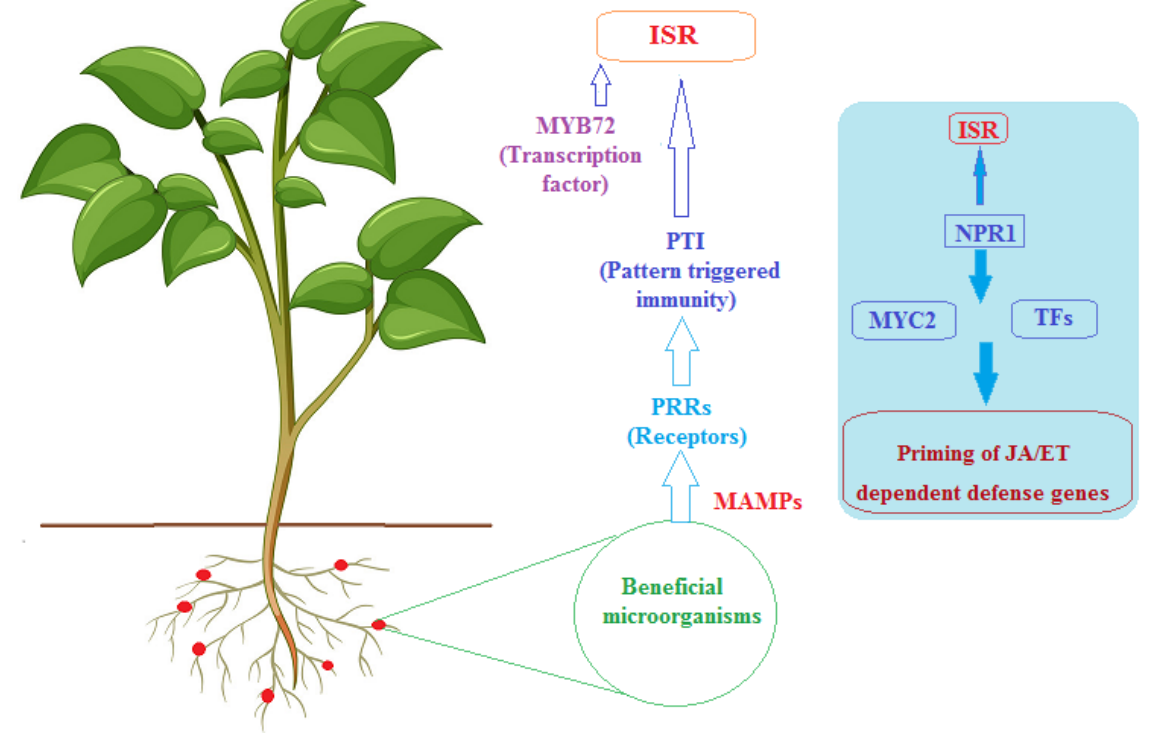
Figure 2. Induced systemic resistance (ISR) by beneficial microorganisms. JA and ET are central regulators phytohormones of ISR, and transcription factors (e.g., MYC2) mediate the increased responsiveness of this pathway to stimulation, known as priming. Transcription factor MYB72, as a root-specific transcription factor and early signaling factor, functions as a node of convergence in ISR elicited by beneficial microbes. (ET, ethylene; JA, jasmonic acid; NPR1, NONEXPRESSOR OF PR GENES1; MAMPs, microbe-associated molecular patterns; PRRs, plant recognition receptors; PTI, PAMP-triggered immunity; TFs, transcription factors).